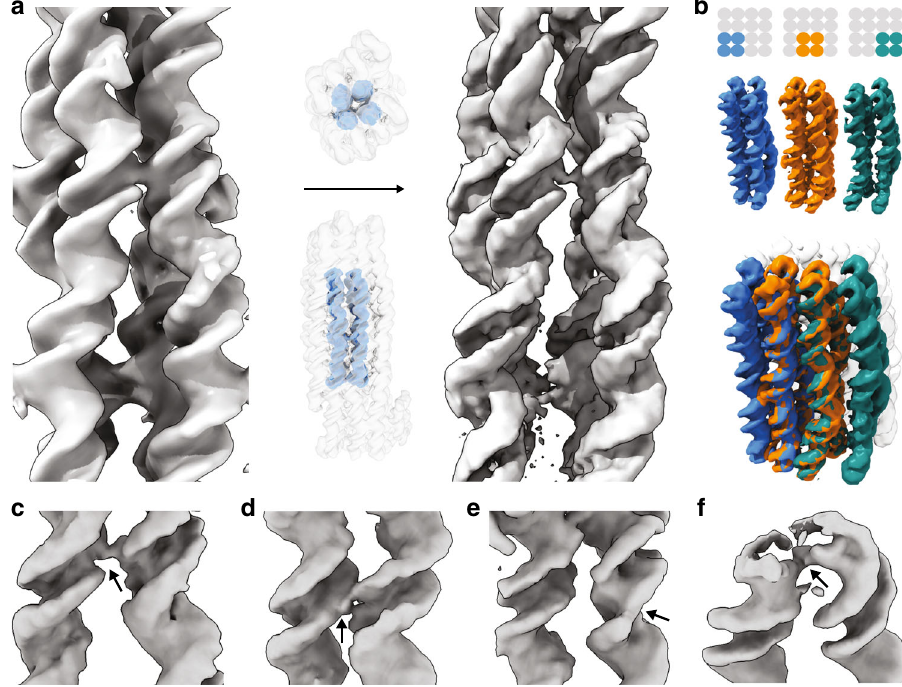
Fig. 4 Scanning-focused re fi nement. a Left: exemplary region of interest in the 4 × 4 domain in the Twisttower cryo-EM map. Right: same region, after two-body re fi nement using the two bodies indicated in the middle. b Schematic illustration of the iterative application of the procedure in ( a ) over the entire object. Bottom: Frankenstein map, created by combining the focal elements. c – f Left to right: arrows give examples of high-resolution features revealed after scanning-focused re fi nement: single-strand phosphate backbone bond, double-strand phosphate backbone bond, depression at a strand- break site, peripheral single-strand crossovers, and density from poly-T tails at a helical interface.